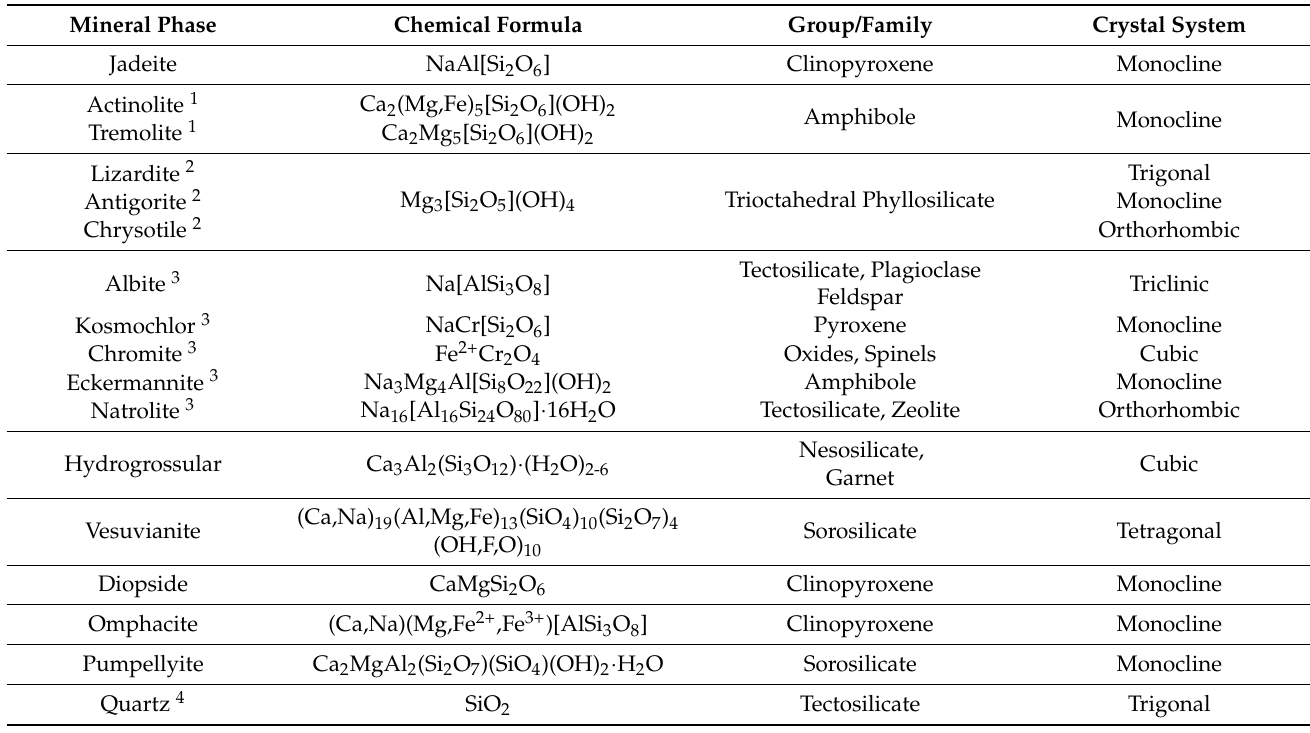
Table 3. Main mineralogical characteristics of Green Stones species here discussed [96,113,114]. For the series, the chemical formula of the end member/pure phase has been